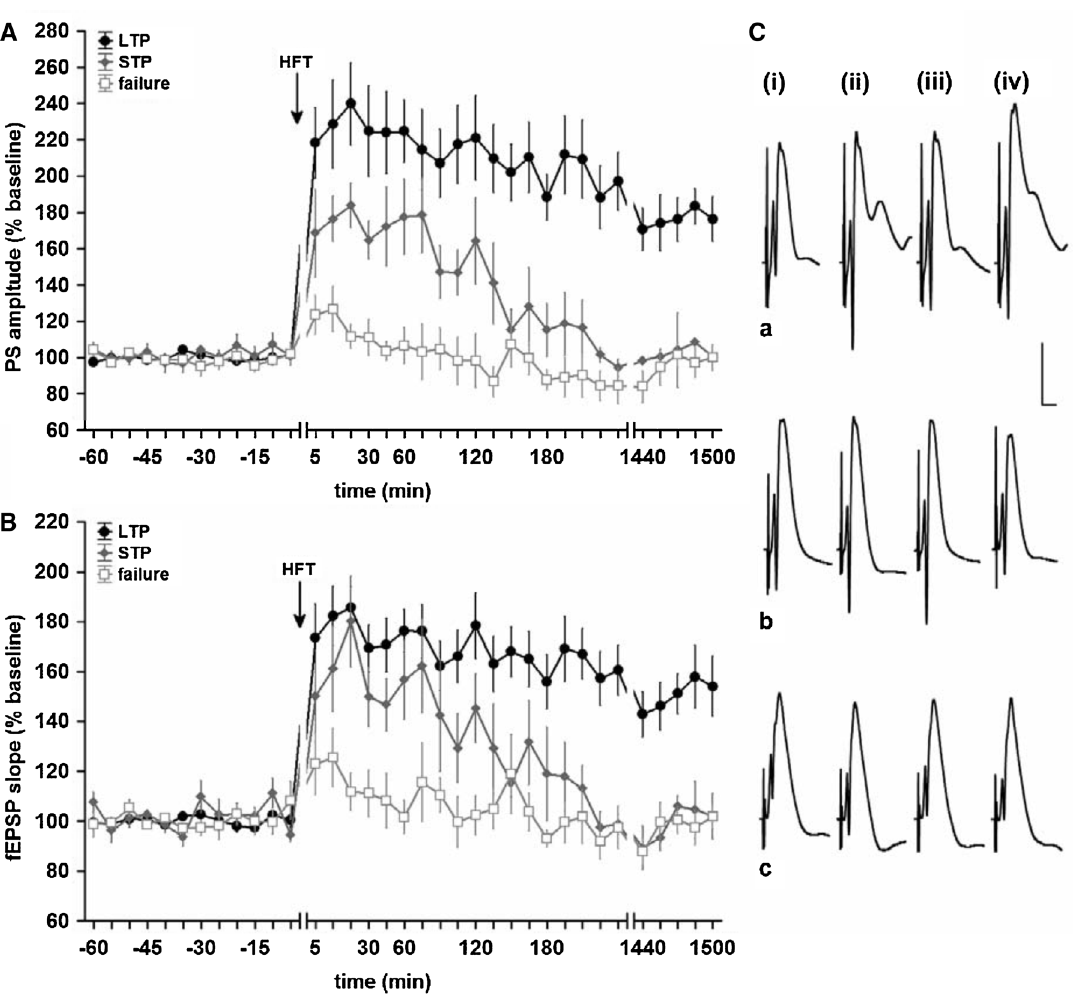
Figure 1. High-frequency tetanisation (200Hz) results in robust LTP that persists for over 24hours, short-term potentiation or failure to produce synaptic plasticity. Data are presented as mean (cid:3) SEM for PS amplitude ( A ) and fEPSP slope ( B ). ( C ) Original analogue traces showing the field potentials evoked in the DG: ( i ) pre-HFT, ( ii ) 5 minutes, ( iii ) 60 minutes, and (iv) 24 hours following HFT in animals that expressed ( a ) persistent LTP, ( b ) STP or ( c ) no change in synaptic strength. Vertical scale bar corresponds to 5mV, horizontal scale bar corresponds to